Question: How would you classify this visualization?
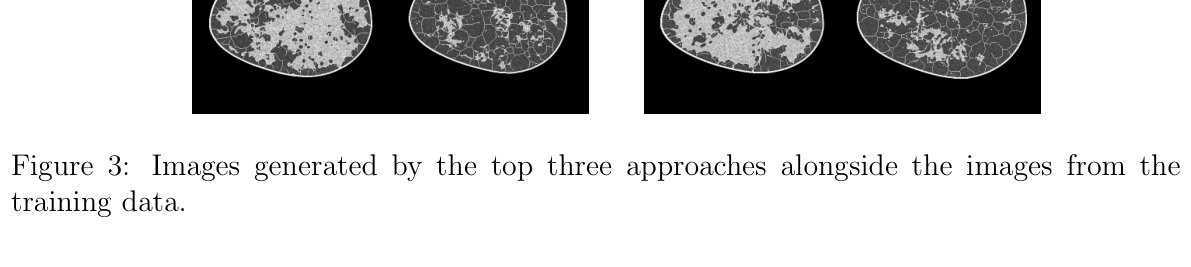
Answer: box